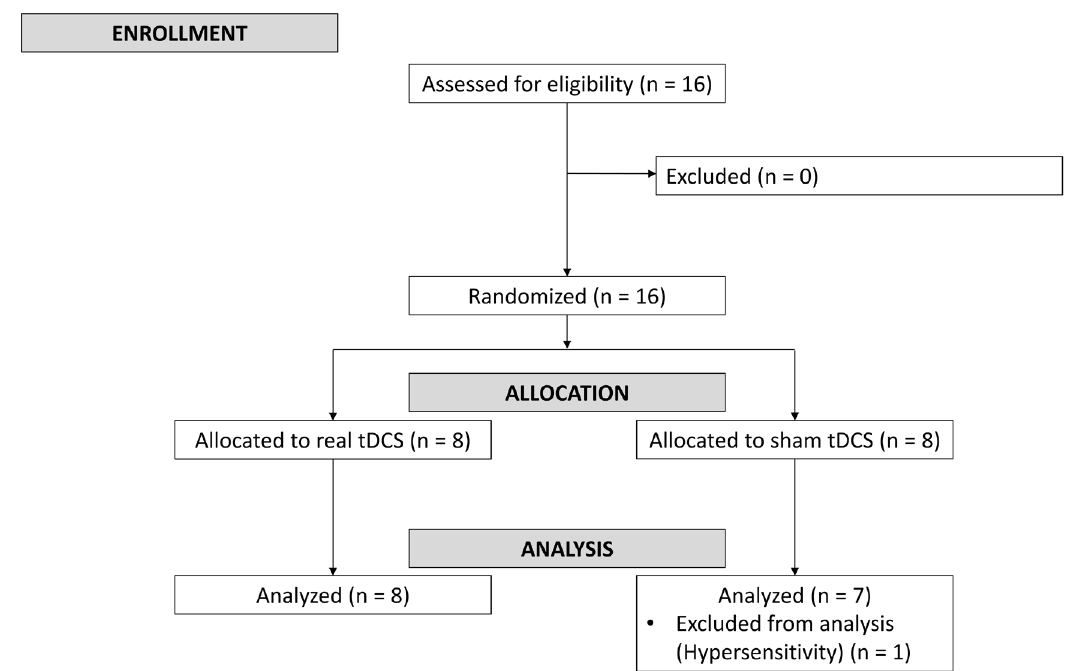
Figure 3. Flow chart of the enrollment procedure (CONSORT 2010 Flow Diagram).